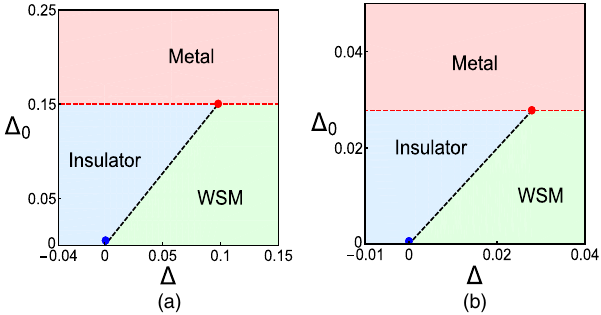
FIG. 21. The phase diagram of a dirty Weyl material residing in close proximity to WSM-insulator QPT, obtained by solving the RG flow equations Eq. (B1) for (a) and Eq. (B5) for (b). Here, Δ is the tuning parameter for WSM-insulator transition in the clean system and Δ 0 is the strength of random charge impurities. These two phase diagrams are qualitatively similar to the one obtained numerically, see Fig. 2 (left), as the WSM-insulator phase boundary shifts toward the semimetallic side with increasing (but weak)